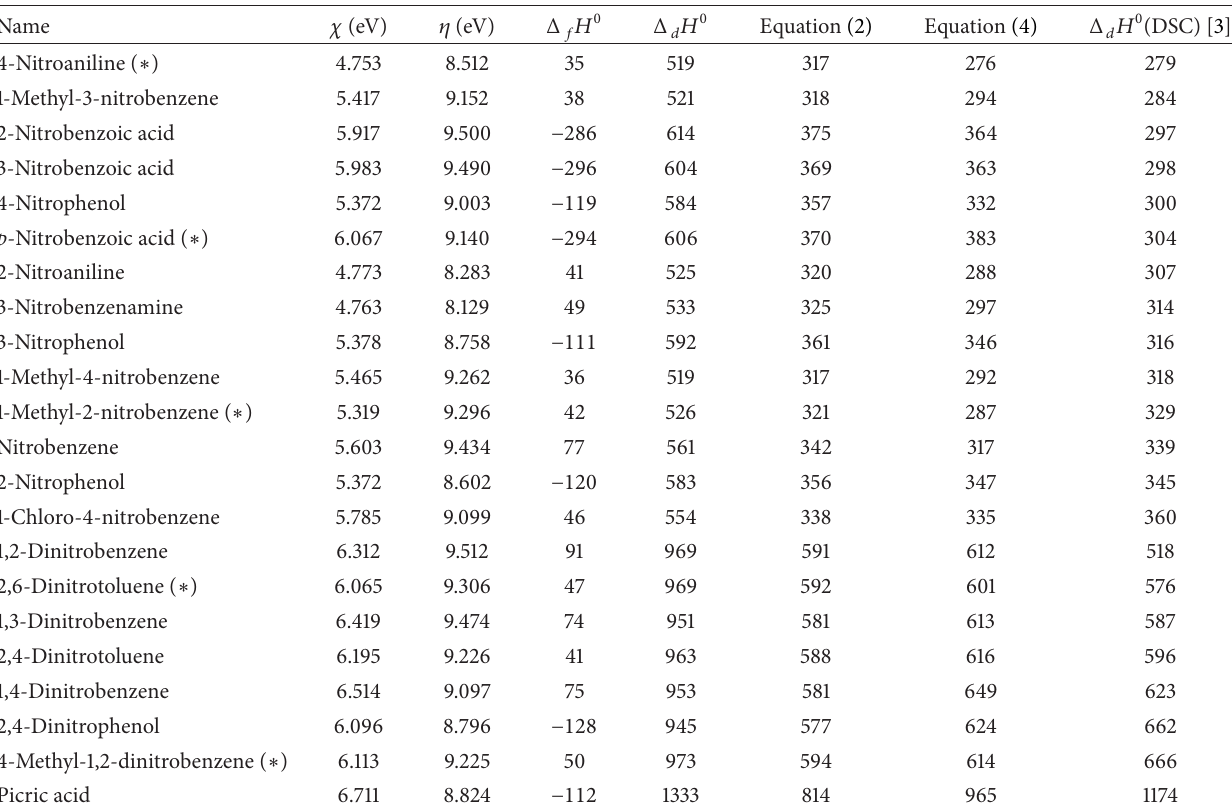
Table 2: Properties of the 22 compounds studied in sealed sample cells: name, electronegativity 𝜒 , chemical hardness 𝜂 , calculated